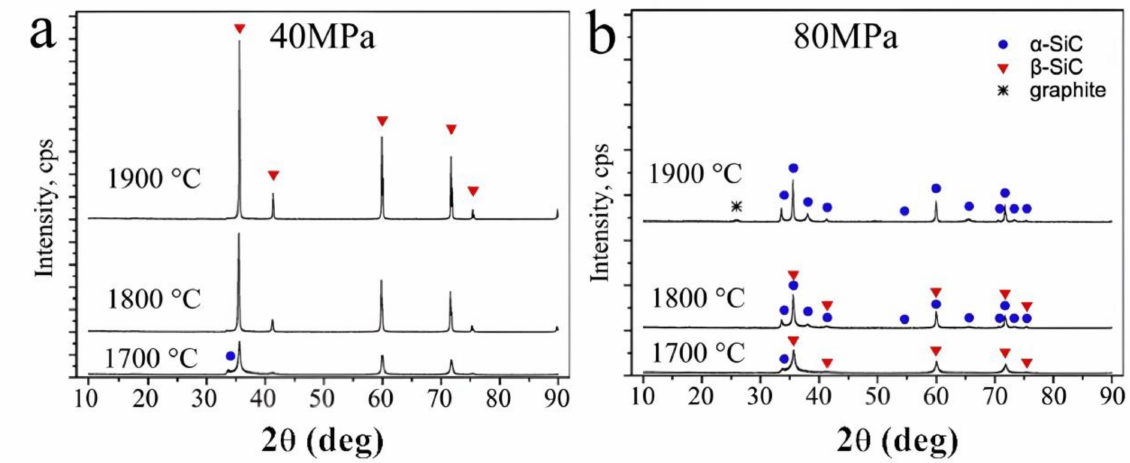
Figure 2. X-ray diffraction patterns (CuK α ) of SPS-processed silicon carbide at ( a ) 40 and ( b ) 80 MPa. The blue symbols represent the diffraction peaks of α -SiC and the red symbols the diffraction peaks of β -SiC